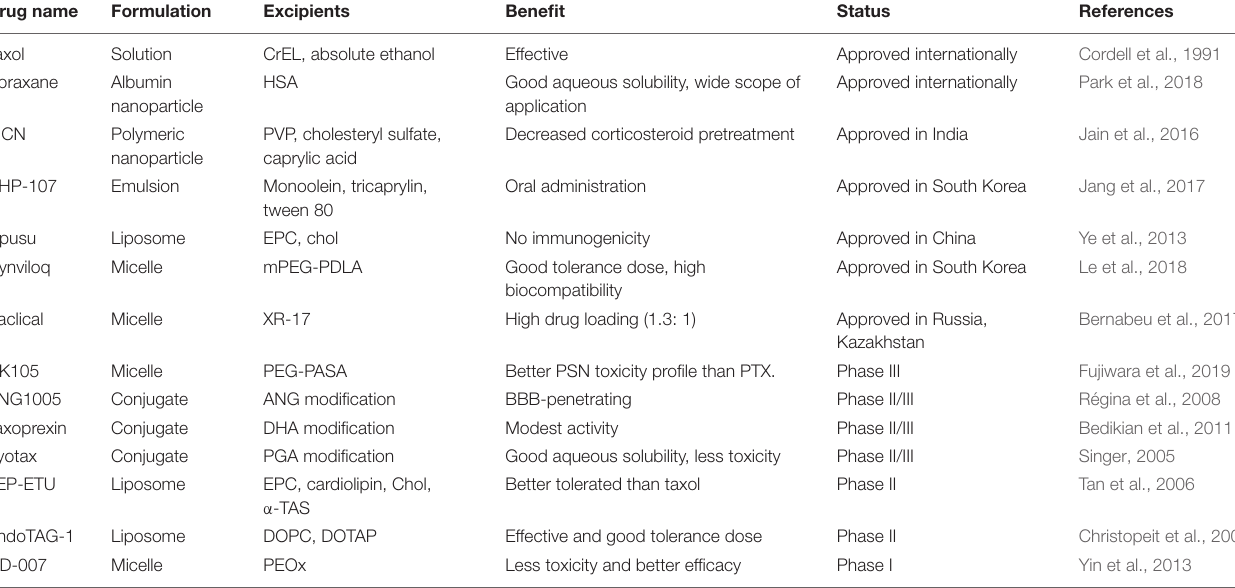
TABLE 1 | PTX anticancer agents in clinical trials.